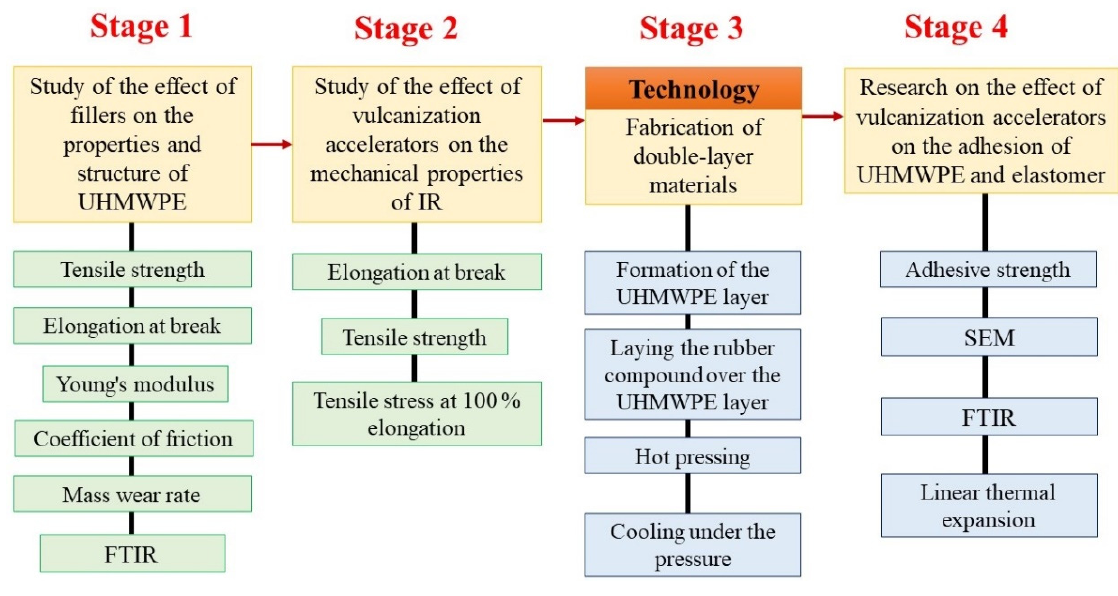
Figure 1. Scheme of the experiment.